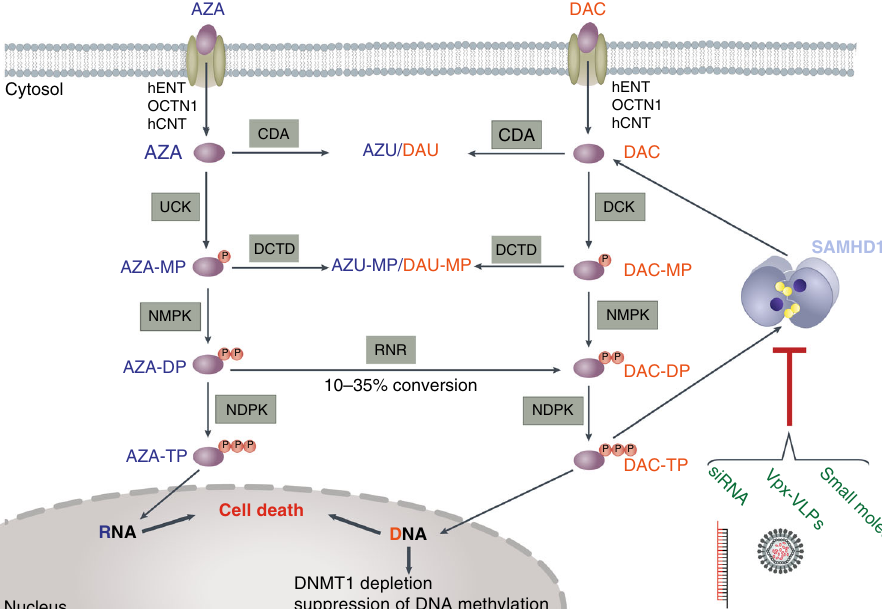
Fig. 7 Scheme of SAMHD1 ’ s role in HMA metabolism and effector functions. Metabolic pathway of DAC and AZA.After their cellular uptake by nucleoside- speci fi c transporters, AZA and DAC are activated and metabolically converted into the active nucleotides AZA-TP and DAC-TP, respectively, by sequential phosphorylation events. Importantly, a fraction of the intermediate AZA-DP can be converted to DAC-DP by ribonucleotide reductase (RNR). DAC-TP, but not AZA-TP, can activate and become hydrolyzed by SAMHD1. Strategies to interfere with SAMHD1 expression and function include degradation through Vpx-carrying virus-like particles (Vpx-VLPs), RNA interference or small-molecule inhibitors of SAMHD1 ’ s triphosphohydrolase activity. See also Supplementary Fig. 1 for details, fi gure created by Dr. Alessia Ruggieri, University of